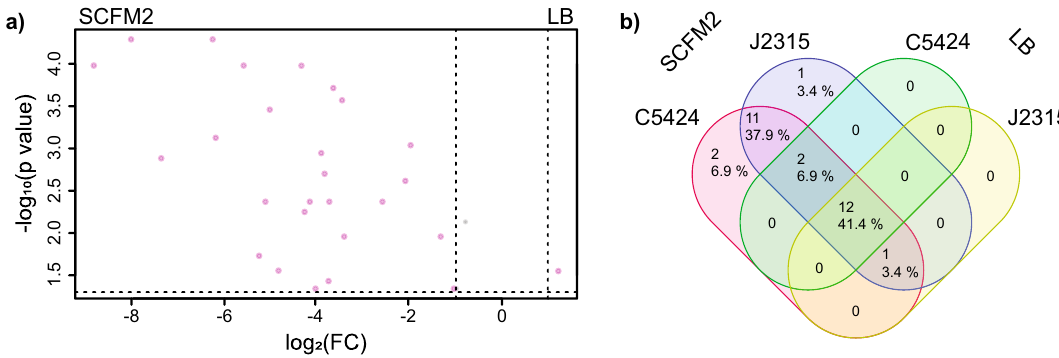
Figure 7. Distribution of metabolites containing trimethoprim motif which were produced by pigmented B. cenocepacia strains (C5424 and J2315) in SCFM2 and LB media. ( a ) Volcano plot showing trimethoprim metabolites which are differentially detected when cultured in either LB (right) or SCFM2 (left). Metabolites exhibiting an absolute fold change greater than 2 and a p value less than 0.05 (indicated by pink dots) were considered differentially detected. ( b ) Venn diagram showing the distribution of trimethoprim metabolites in C5424 and J2315, cultured in SCFM2 and LB